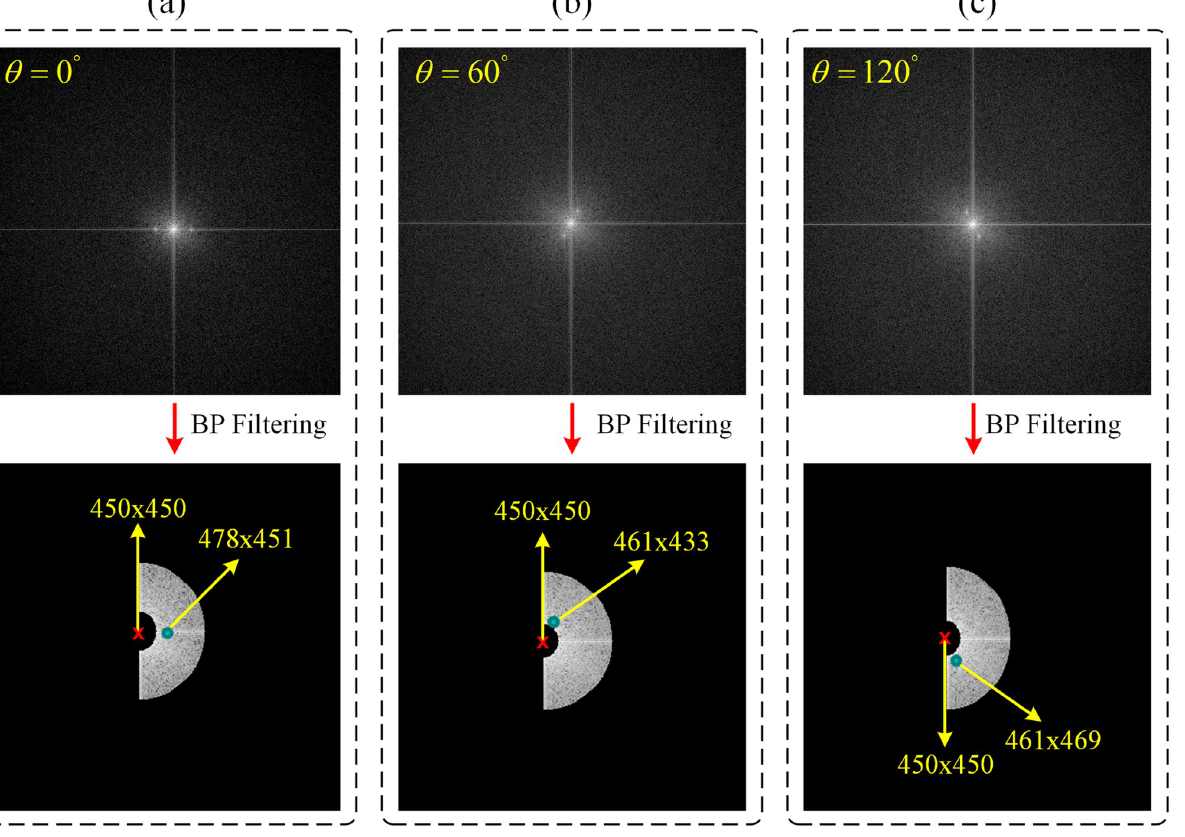
PLOS ONE | https://doi.org/10.1371/journal.pone.0273990 September 9,